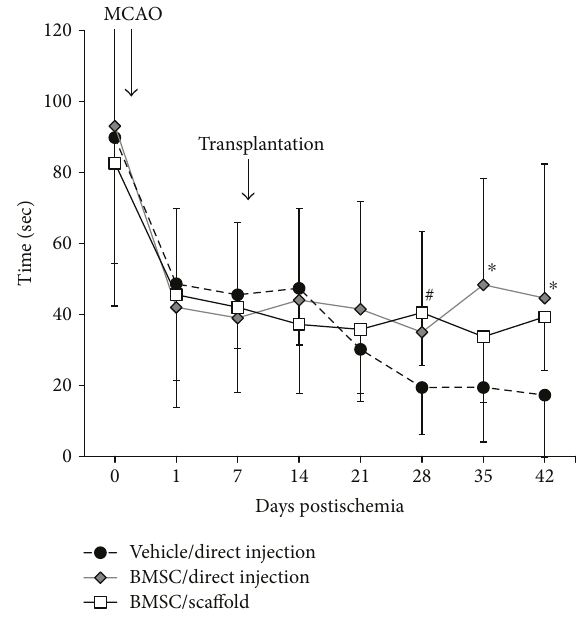
Figure 5: Rotarod test. The line graph shows the mean time on a rotarod treadmill for each group. Black circles: the vehicle/direct injection group; shaded diamonds: the BMSC/direct injection group; white squares: the BMSC/sca ff old group. Error bars show SD; # P < 0 05 in the BMSC/sca ff old group versus the vehicle/ direct injection group, ∗ P < 0 05 in the BMSC/direct injection group versus the vehicle/direct injection